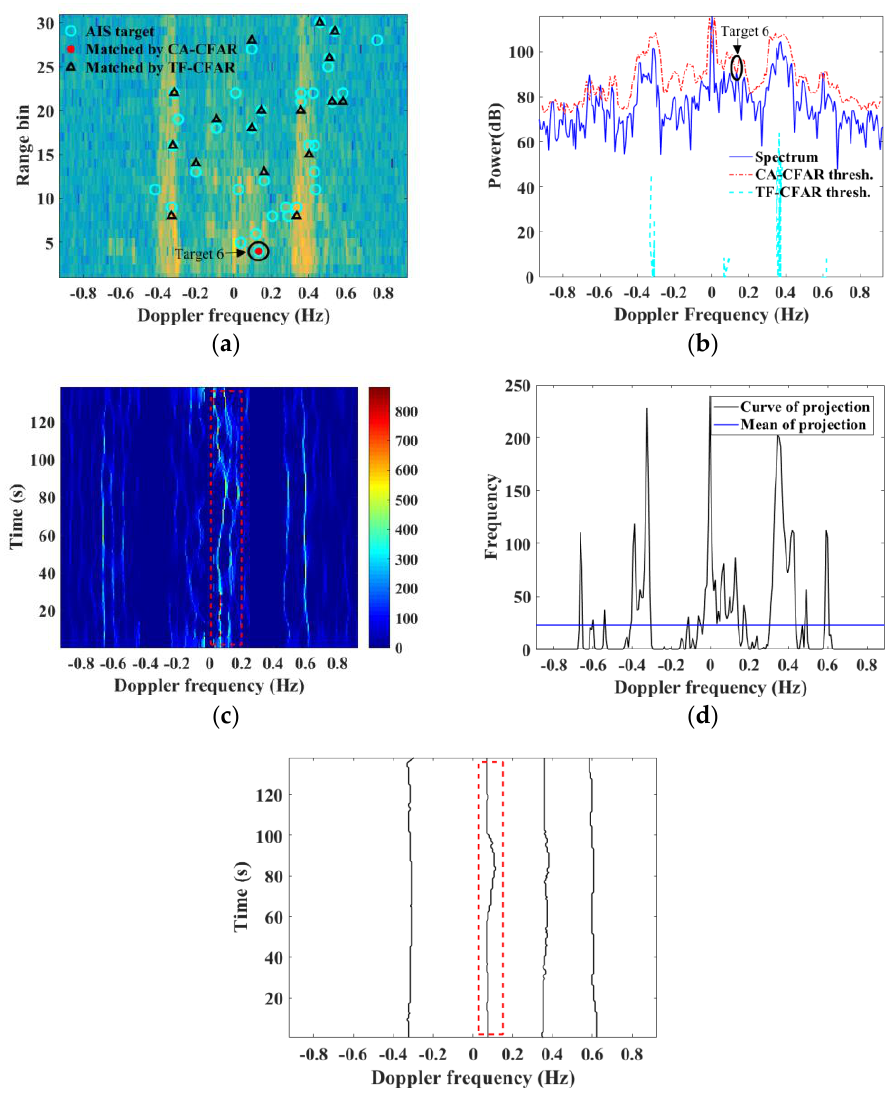
Figure 10. Target matched by CFAR but unmatched by TF-CFAR at 06:51 on 25 September 2015. ( a ) target-matching map; ( b ) power spectrum; ( c ) TF image; ( d ) gray projection curve; ( e ) TF ridge extraction. ( b – e ) are all at the 4th range bin.